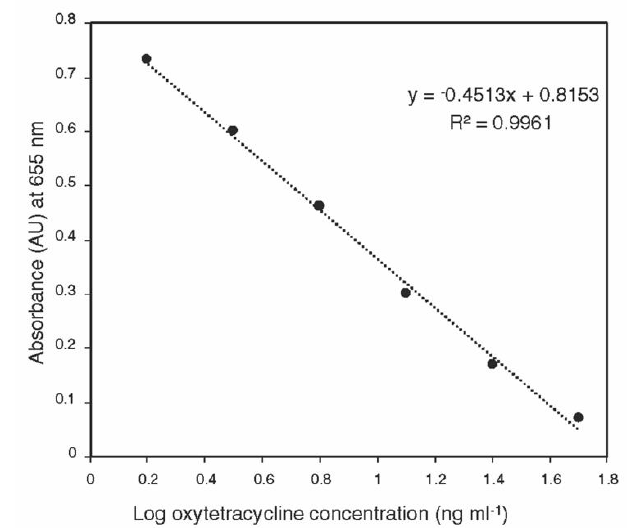
Figure 1. Calibration curve of oxytetracycline generated using ACCEL ELISA kit over the detection range (1.5–50 ng ml −1 ).